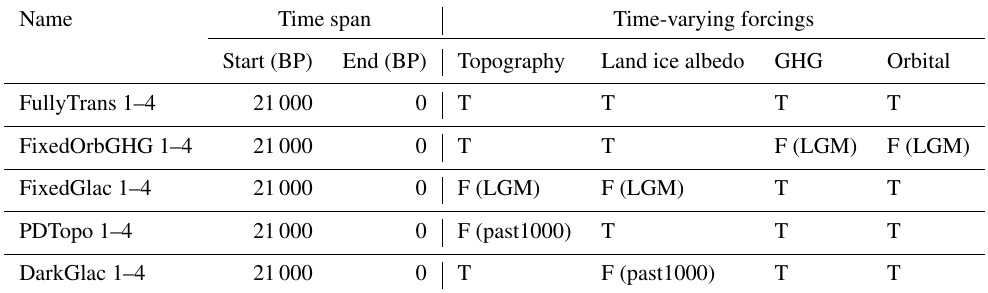
Table 1. Characteristics of numerical simulations presented in this study. The time-varying forcings are described in Sect. 2.2 and are either transient (T) or fixed (F). Topography includes ice sheet topographic variations as well as corresponding changes to surface roughness and land mask. GHG represents greenhouse gas changes enacted through effective CO 2 concentrations.